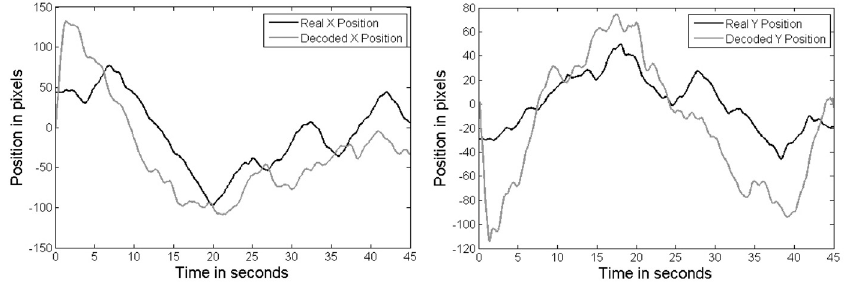
Fig 4. Example of a decoded trajectory for Subject 4. Horizontal axis (left) and vertical axis (right).